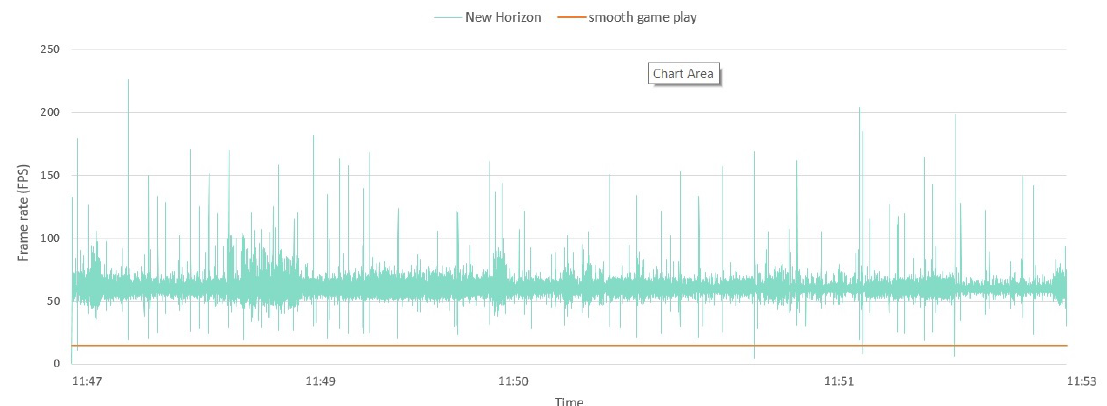
Figure 9. The frame rate in fps during a gaming session. During the gaming session, the player has flown his spaceship through the universe and has played each type of mini-game once. To achieve ‘smooth’ gameplay, the frame rate has to be higher than 15 fps. Test performed on a Google Pixel XL with Android